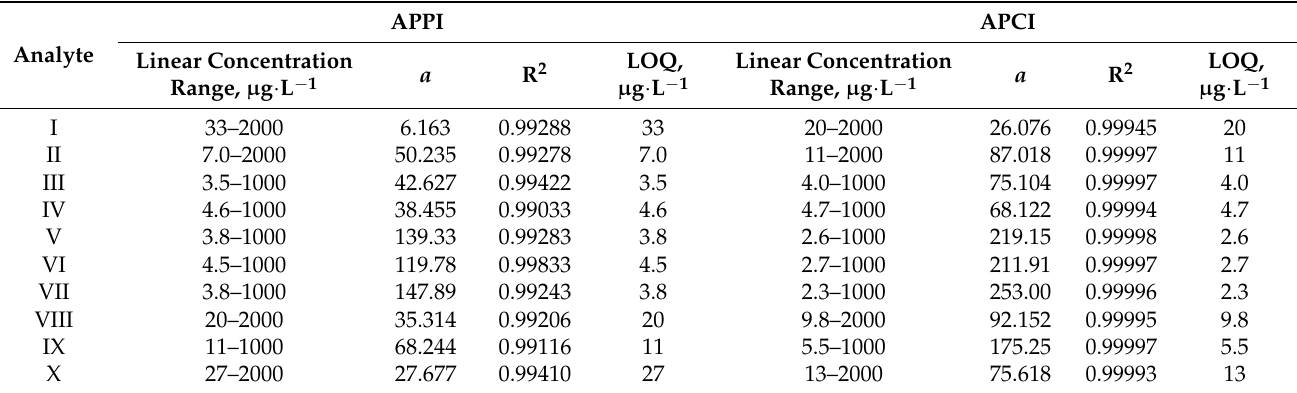
Table 2. Calibration dependences ( y = a × x ) for the area of chromatographic peak versus analyte concentration, limits of quantification of analytes by SFC–APCI–MS/MS and SFC–APPI–MS/MS methods on HSS C18 SB stationary phase.